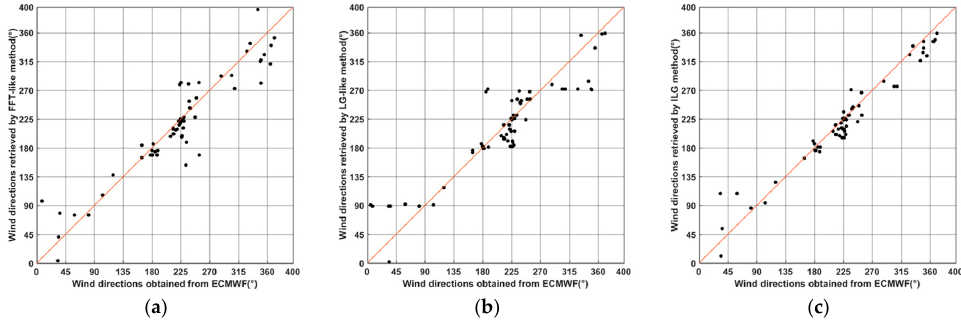
Figure 6. Comparison of wind directions between each retrieval method and ECMWF: ( a ) fast Fourier transform (FFT)-like method, ( b ) local gradients (LG)-like method, ( c ) ILG method.